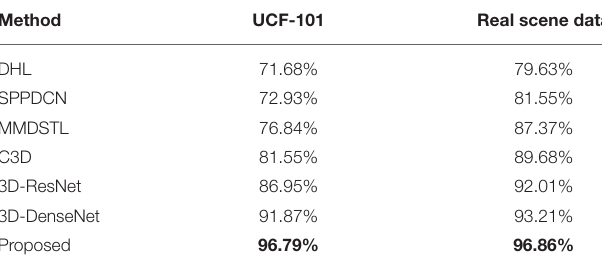
TABLE 4 | Confusion matrix with proposed method on KTH data set. True label Jogging